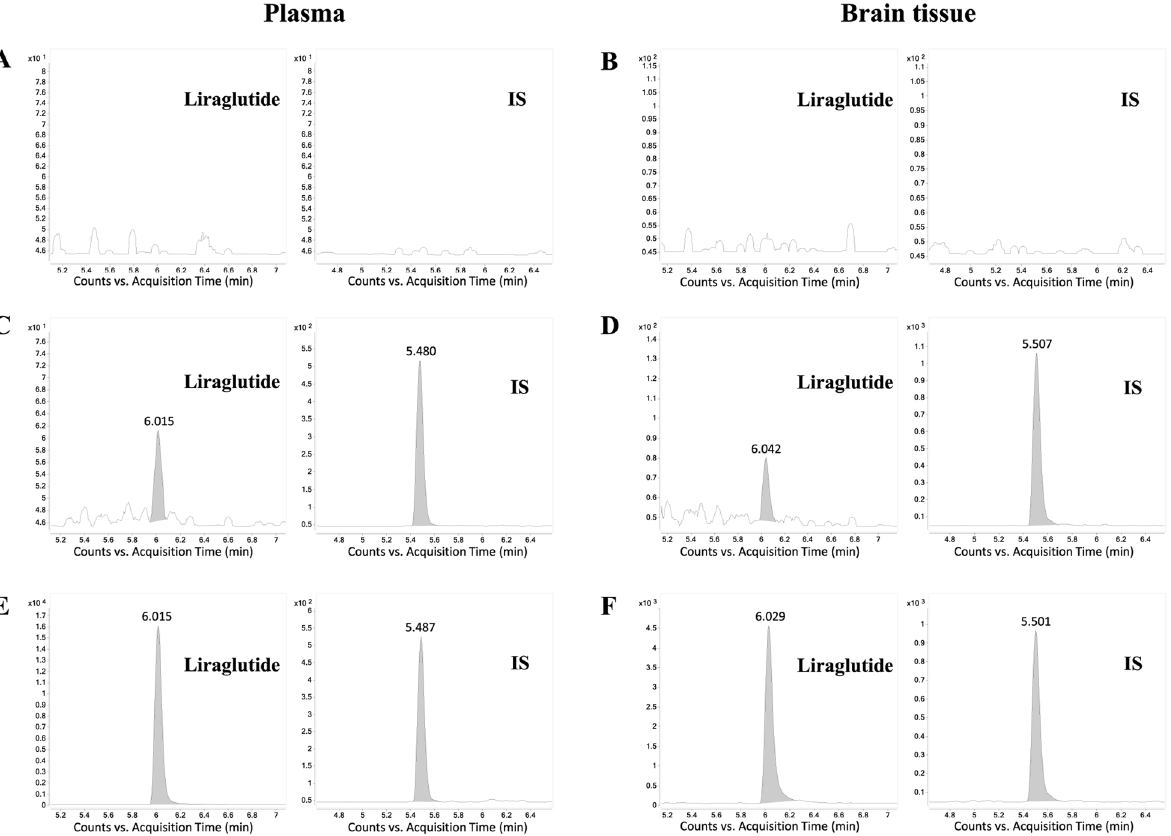
Fig. 2 Representative chromatograms of liraglutide (left) and IS (right) obtained from A blank plasma, B blank brain tissue, C LLOQ concentration of liraglutide and IS in the plasma, D LLOQ concentration of liraglutide and IS in the brain tissue, E ULOQ concentration of liraglutide and IS in the plasma, and F ULOQ concentration of liraglutide and IS in the brain tissue